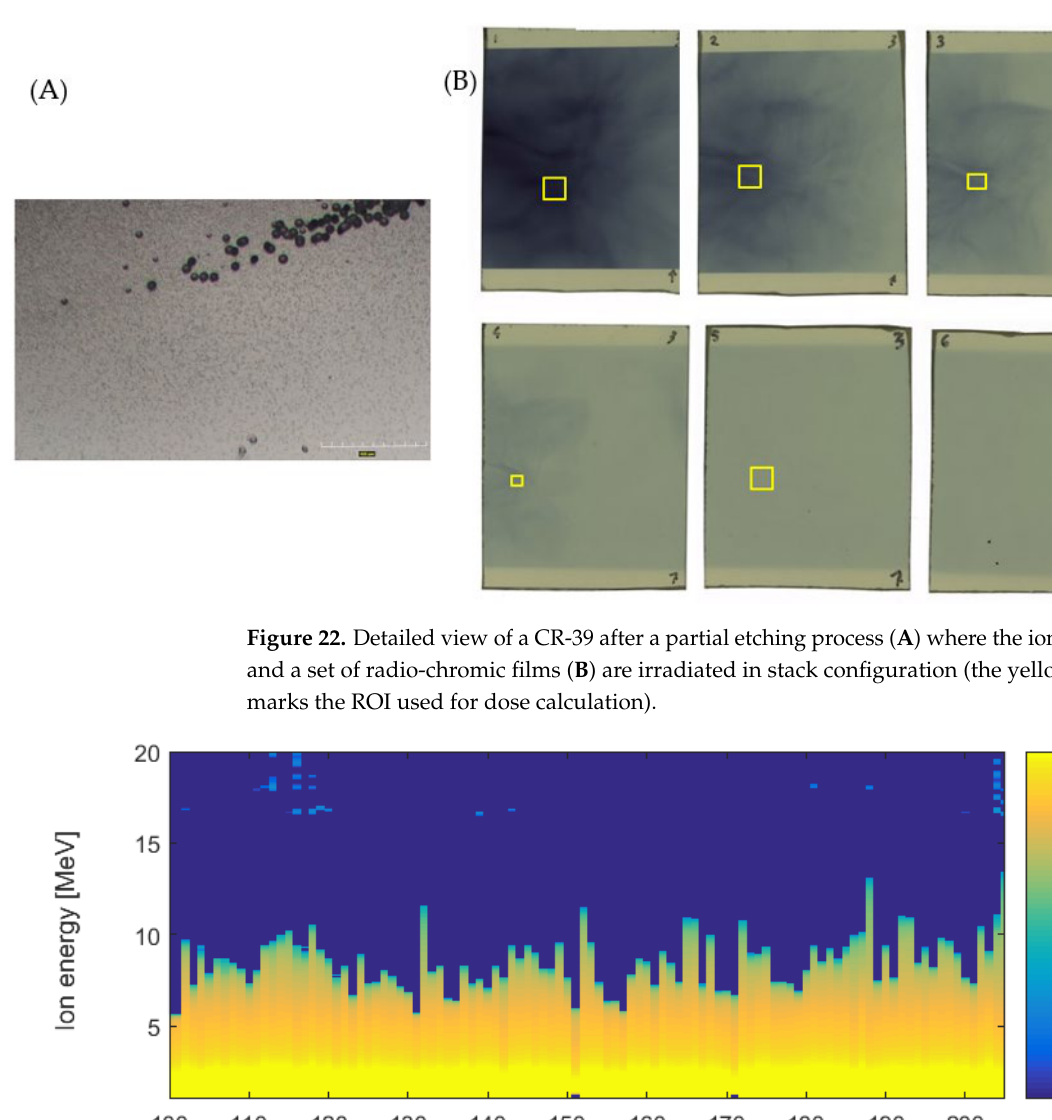
Figure 24. Pie chart showing the total number of shots fired per target material . During the ELIMAIA technical commissioning, several activities were carried out to optimize and improve the whole accelerator technology, including procedures necessary to align and deliver the L3 laser with high intensity onto a target. Additionally, data ac- quisition and analyses in real time were tested with the goal to provide reliable and unique feedback in terms of laser, plasma, and ion diagnostics to future ELIMAIA users. Besides debugging the sophisticated Ion Accelerator equipment and laser/plasma diagnostics